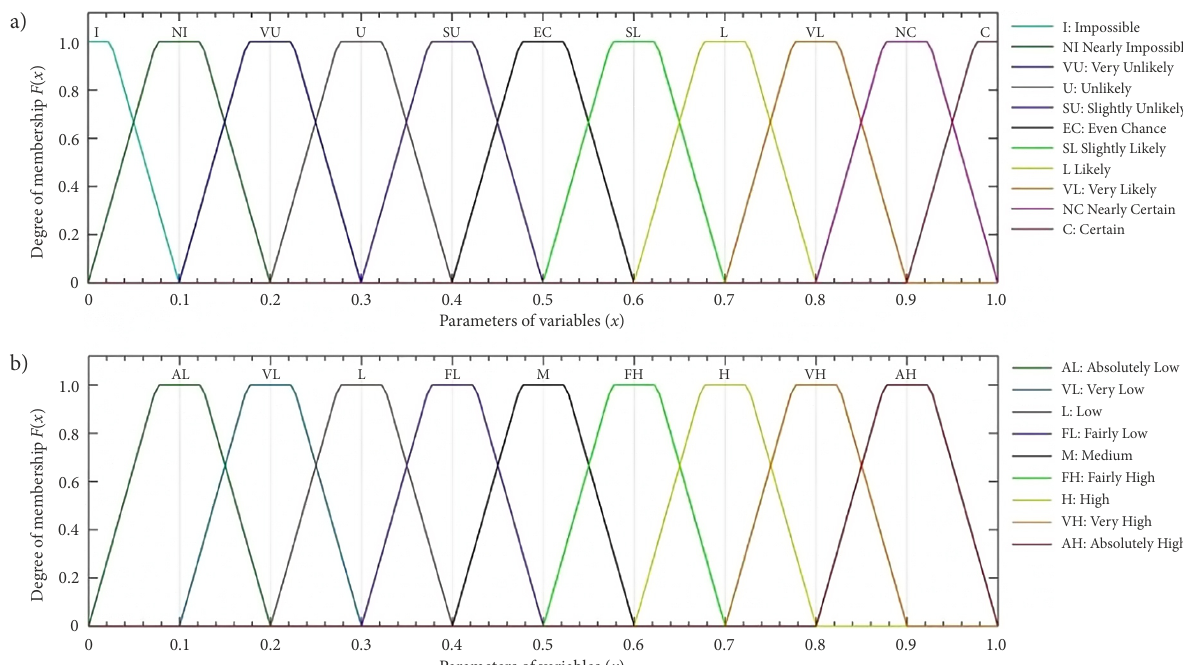
Figure 5. a) The 11-point linguistic scale and corresponding fuzzy membership functions for assessing occurrence probabilities (OPs) of RFs; b) The nine-point linguistic scale and corresponding fuzzy membership functions for assessing magnitudes of impact (MIs) of RFs